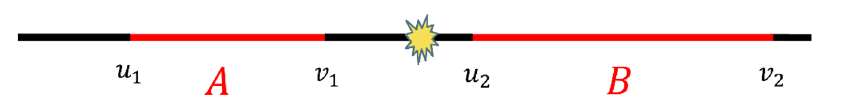
Figure 1 . We study the setup 0 < u 2 < − v 1 < − u 1 < v 2 . We excite the vacuum by inserting a local operator at the origin at t = 0 .